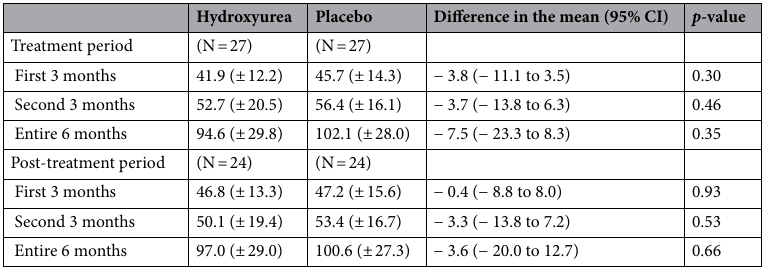
Table 2. Blood transfusion volume (mL/kg) during the treatment and post-treatment follow-up periods. Data are mean (± SD).